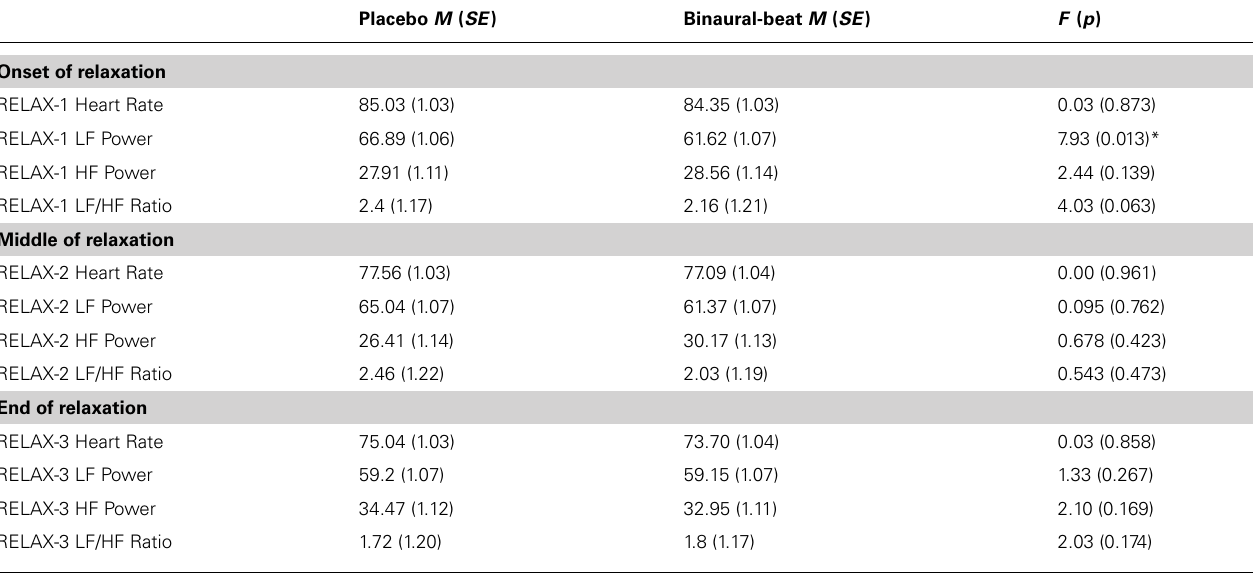
Table 3 | Marginal heart rate variability means at onset, middle, and end of relaxation protocol.